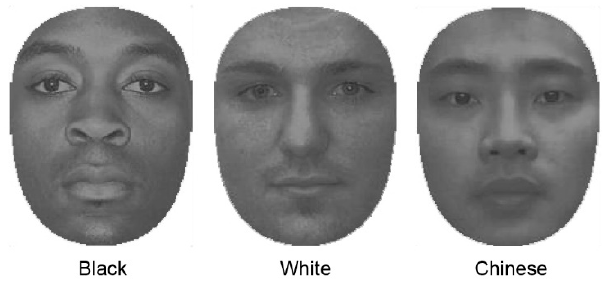
Figure 1. Sample images of the Black, White, and Chinese face stimuli. For each image, all hair and the ears were cropped such that each face was presented masked by an oval window 5.1 × 6.9 deg in size. The selected faces were matched in terms of mean luminance and contrast, as referenced against a mean face (mean luminance of 6.89 cd/m 2 ), computed as the average of all faces collapsed across race categories.